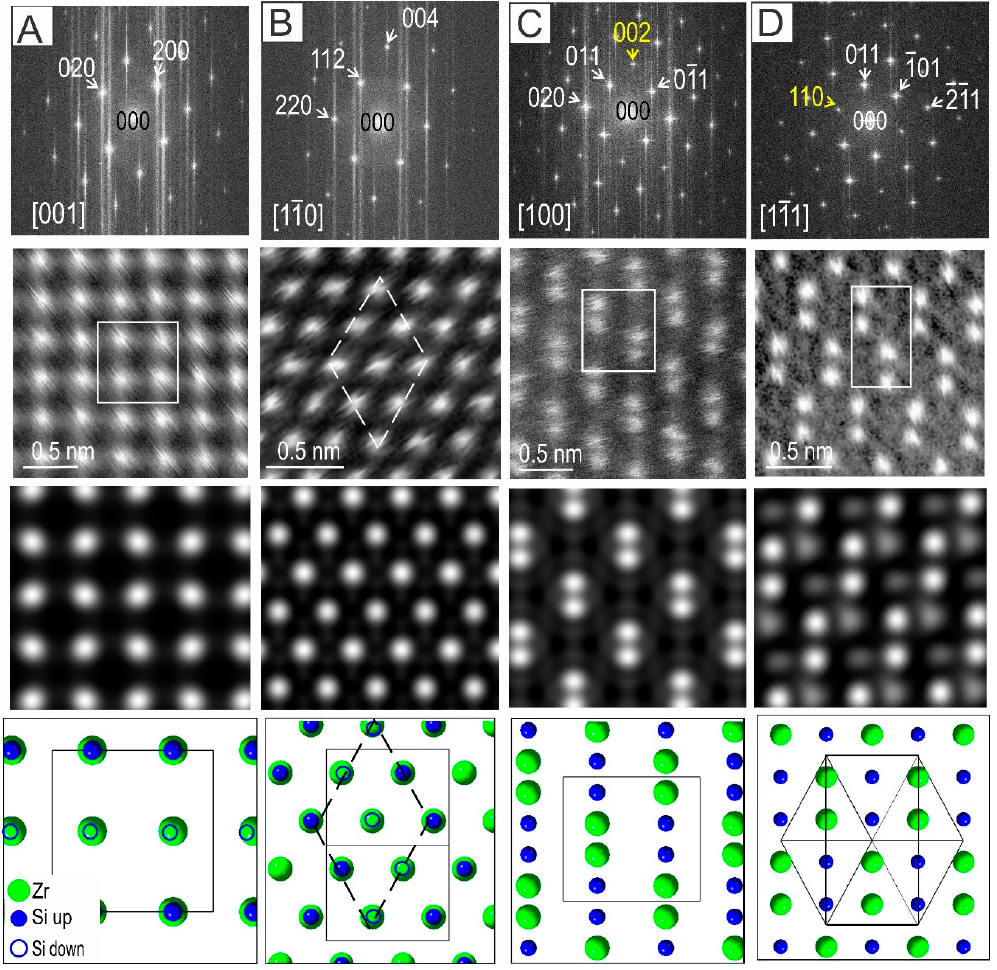
Figure 13. From top to bottom, FFT, HAADF image, STEM simulation, and crystal structure model for each of the main zone axes ( A–D , as marked) imaged in zircon (Figure 12). The images and simulations were interpreted in agreement with crystal structure models on zone axes as obtained from indexing FFTs obtained from images in Figure 11. The two zone axes with dumbbell atomic arrangements ( C , D ) cannot be resolved using the ideal space group for zircon, I 4 1 / amd, due to the presence of forbidden reflections (00 l ; l ≠ 4 n and hh 0; l ≠ 4 n ; marked in yellow). Indexing, crystal models, and STEM simulations were obtained using the I 2 1 2 1 2 1 space group. The models and simulations did not change when using the I 4 1 / amd space group.